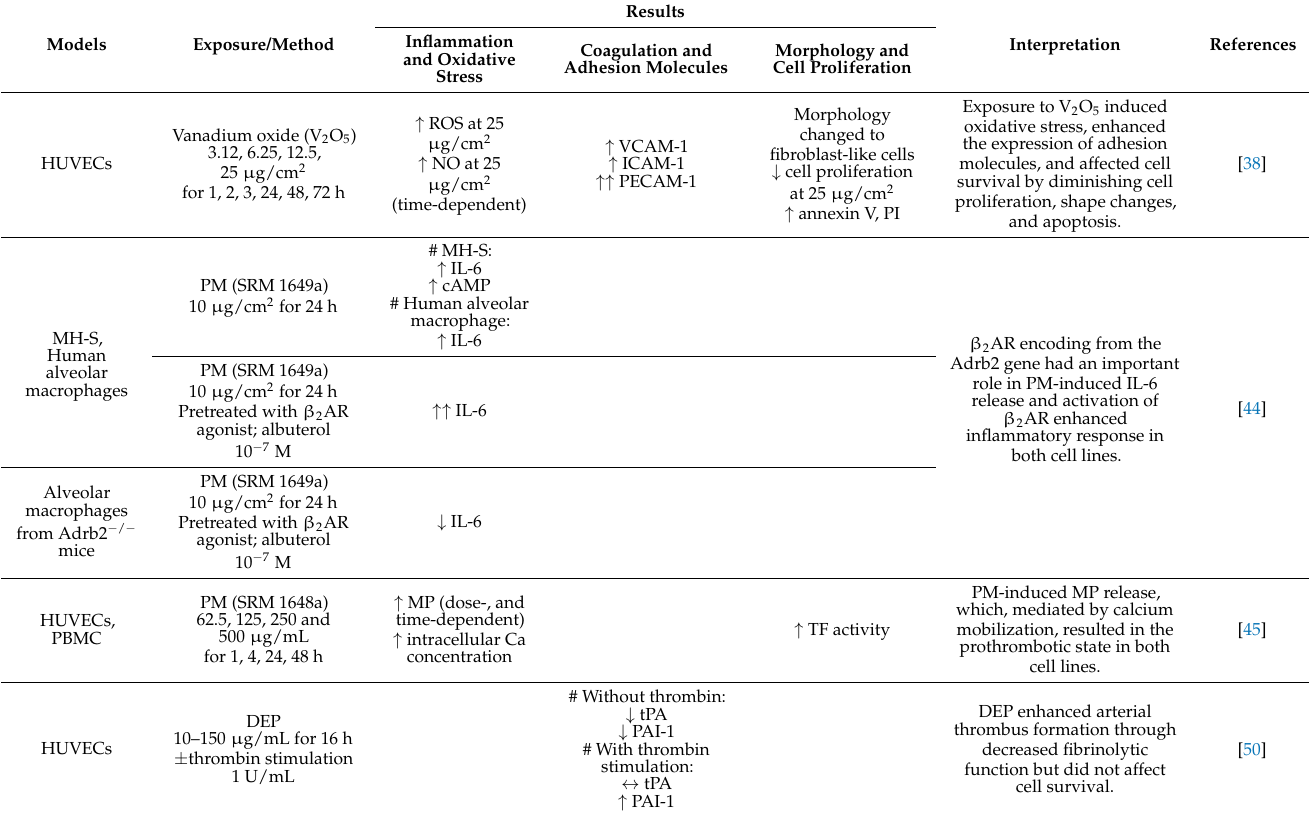
Table 1. The effects of particulate matter on inflammation, oxidative stress, adhesion molecules, and hemostatic changes: Evidence from in vitro